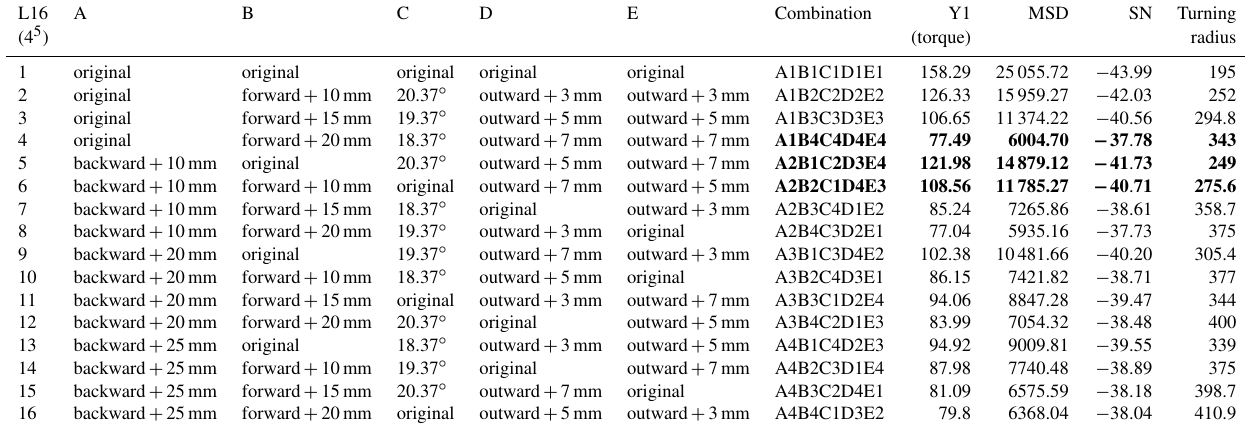
Table 7. First-stage Taguchi experiment. The combinations in bold font meet the requirements of reducing the steering radius and steering torque as much as possible. MSD represents mean square deviation, and SN represents the signal-to-noise ratio.